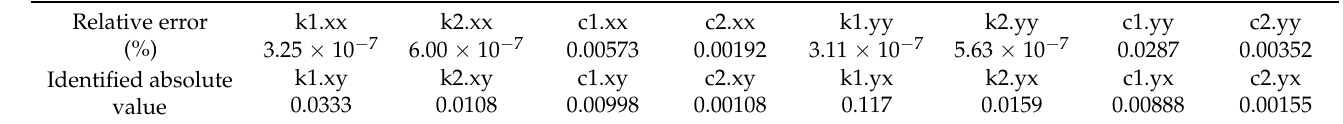
Table 9. The biggest relative identification errors of main coefficients and the maximum identified absolute value of cross-coupled coefficients using